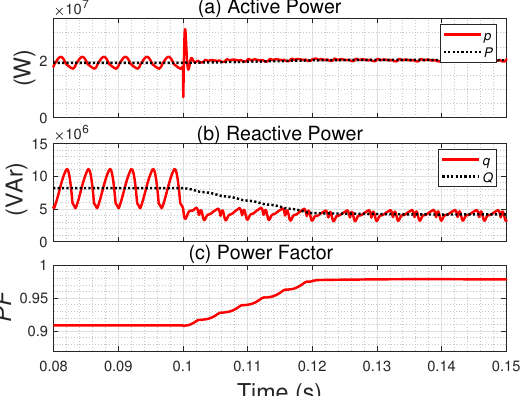
Figure 10. Waveforms of power and PF at the MV2 bus (PCC) in Case 3: ( a ) Active power, ( b ) reactive power and ( c ) Power factor (FP).